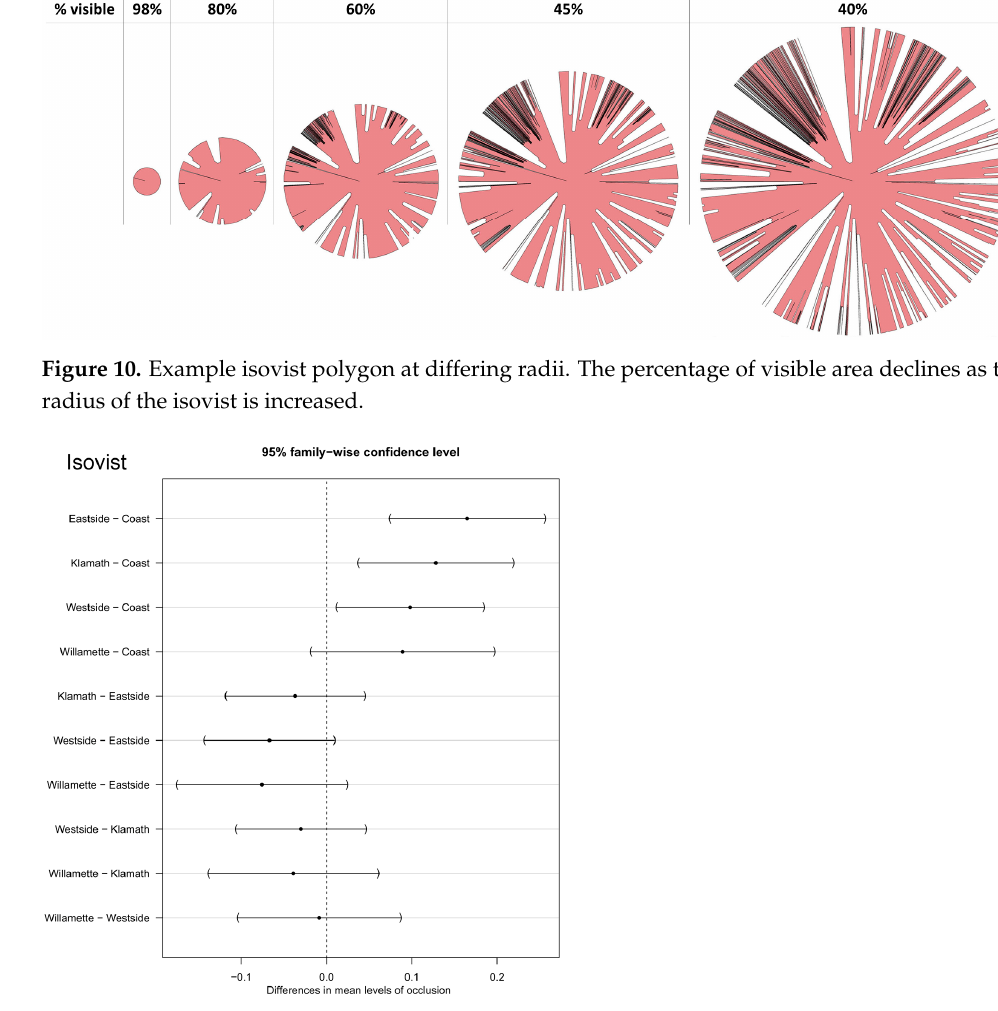
Figure 11. Tukey HSD paired comparison between isovist values grouped by ecoregion.